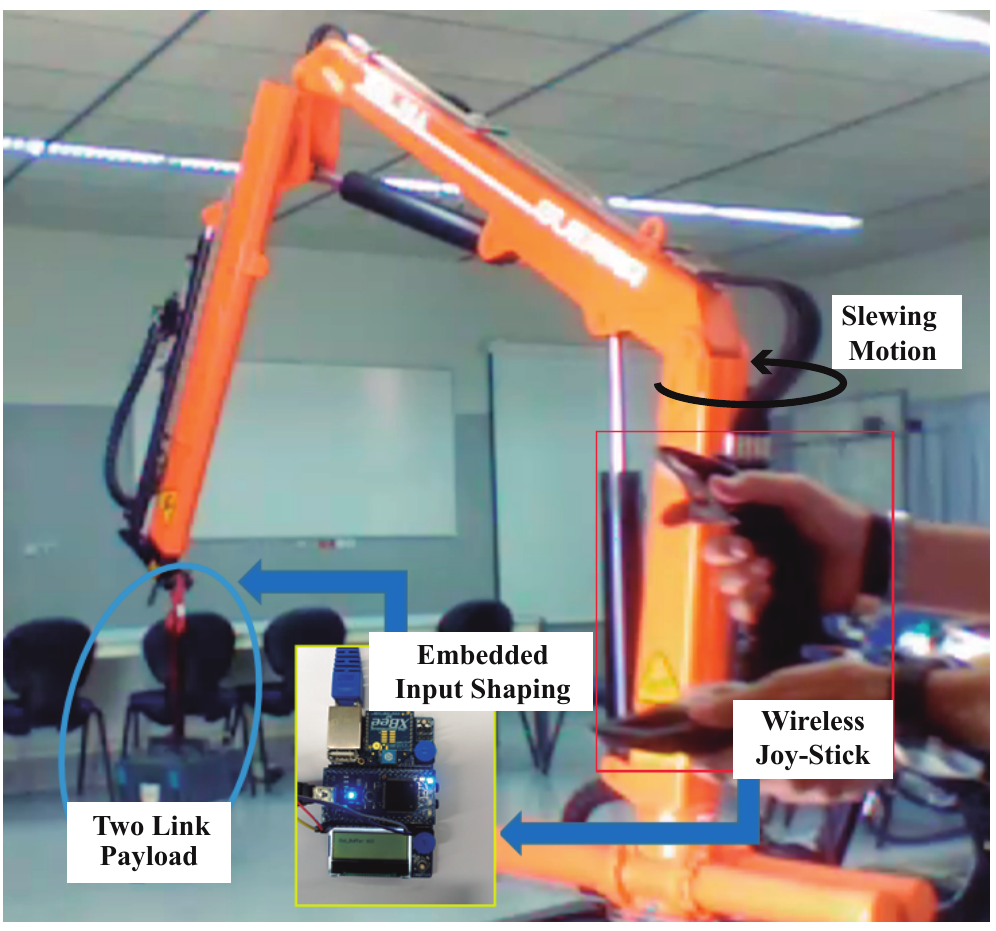
Figure 25. The hydraulic crane at the laboratory for the